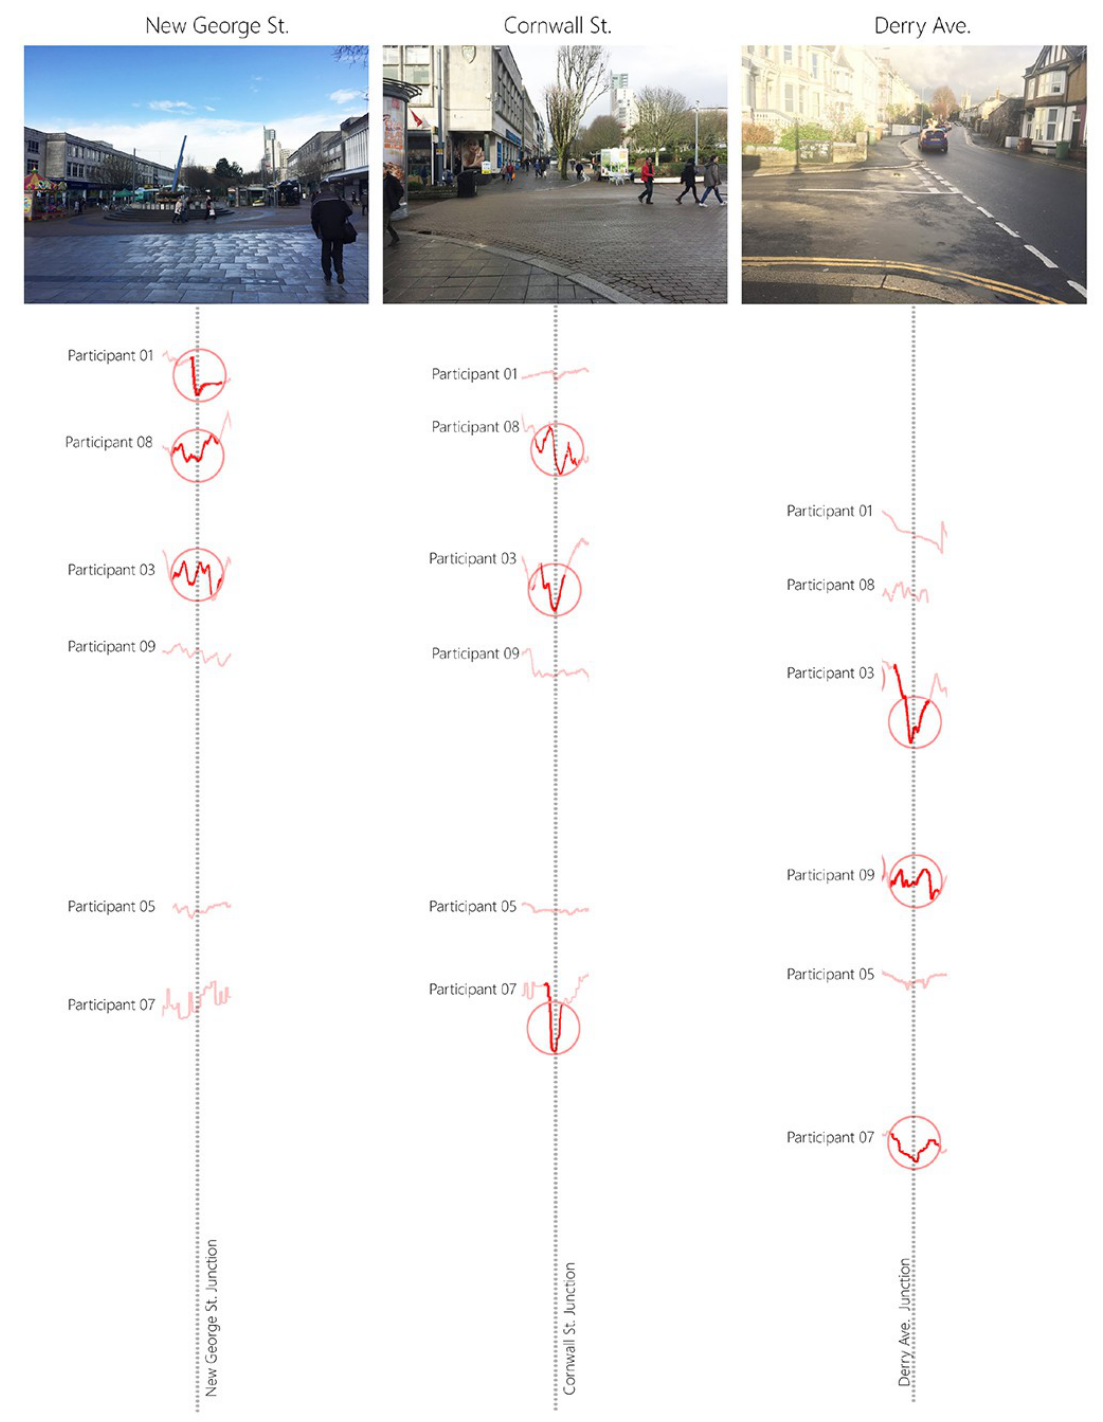
Figure 12. Derry Ave. crossing and junctions at New George St. and Cornwall St. on the contrary, recorded the lowest number of participants (3 participants) that experience the stress ‘peak’.